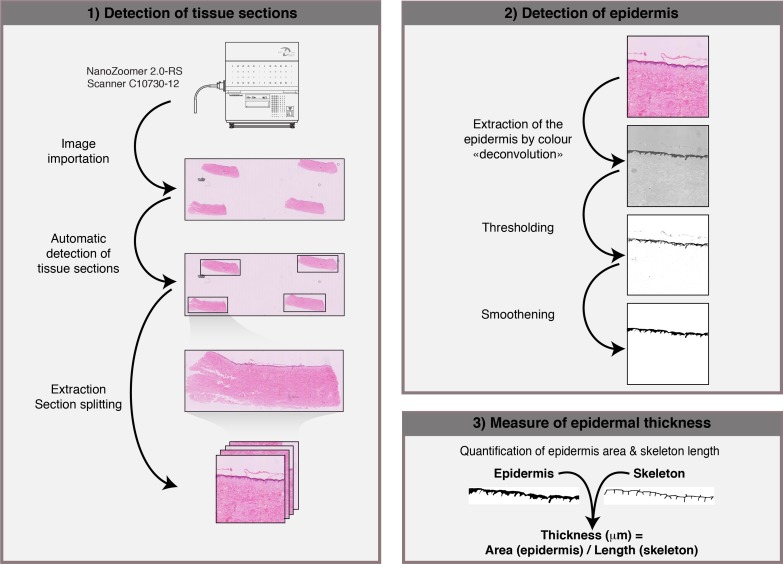
Workflow for automated quantification of the epidermal thickness.Sketch representing the automated pathway to extract epidermis thickness from tissue sections. The python script was divided into three steps. (1) Detection of tissue sections by processing from ‘.ndpi’ files. With intensity clustering, the background was suppressed and tissue sections were localised on the slide. Each section was extracted with the highest resolution and split into four vignettes. (2) The epidermis was isolated using information from H and E staining in each vignette. An automatic thresholding was applied to select only the epidermis. Potential artefacts that were small in size were suppressed by thresholding on each object’s size. (3) Epidermal area was measured by pixel counting. To measure epidermal thickness, area was divided by a 1-pixel wide reduced-topology.